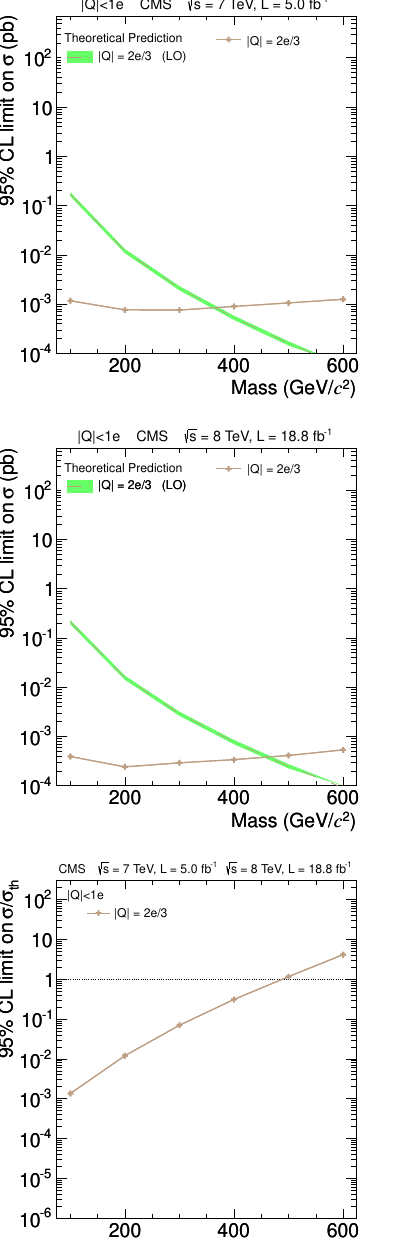
Theoretical Prediction |Q| = 2e/3 (LO)